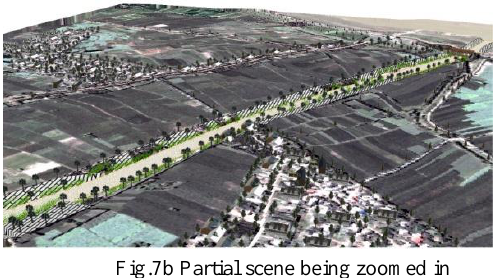
Fig.7b Partial scene being zoomed in